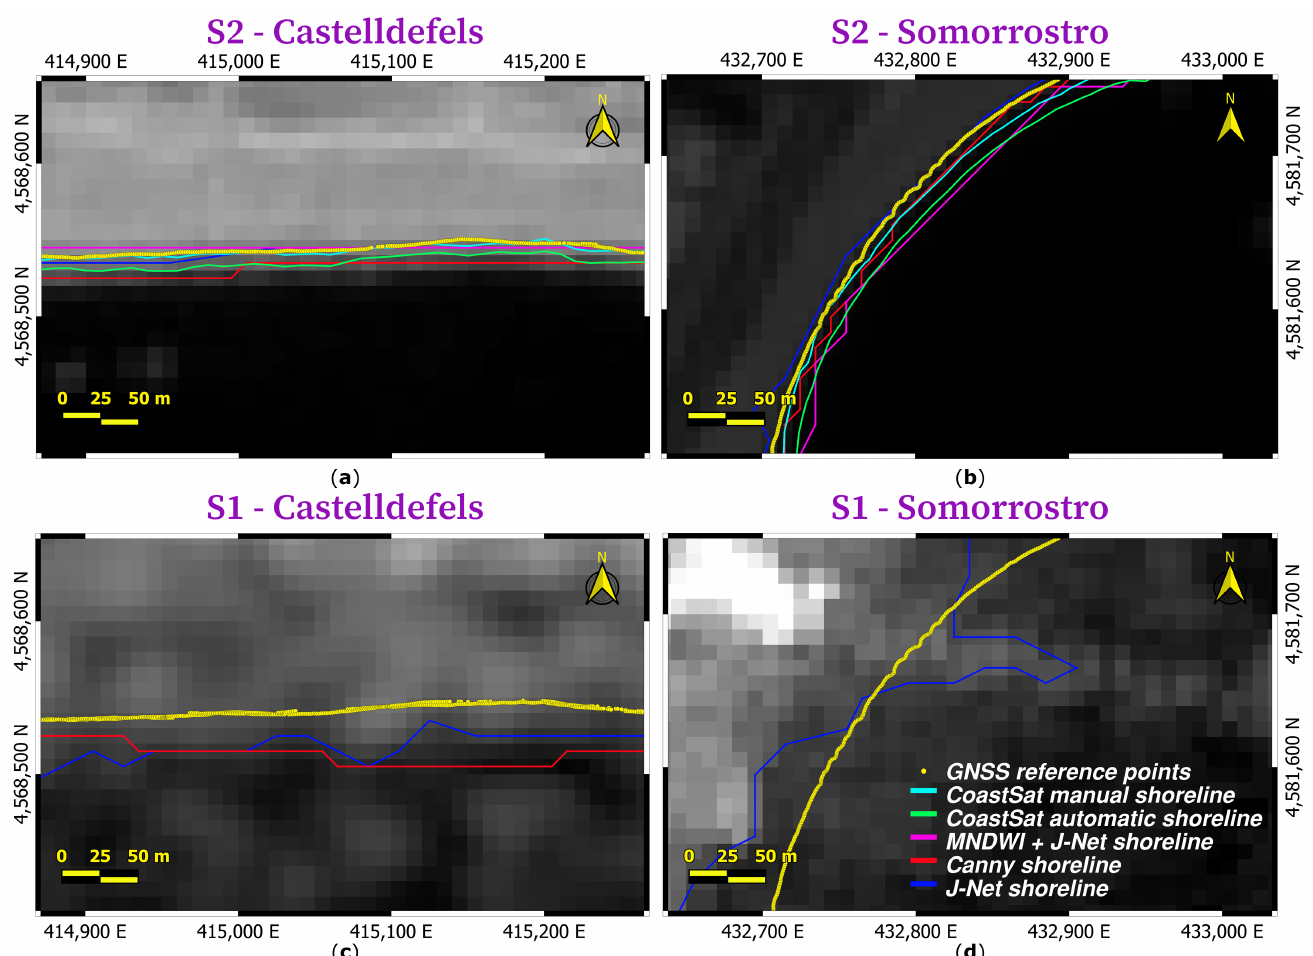
Figure 6. All extracted shorelines: ( a ) S2 Castelldefels, date 2017/06/02, ( b ) S2 Somorrostro, date 2017/10/10; ( c ) S1 Castelldefels 2017/05/31; ( d ) Somorrostro, dates 2017/10/04. GNSS reference points (yellow); CoastSat shoreline extracted with manual (light blue) and automatic (red) thresholds; shoreline extracted by J-Net Dynamic over the MNDWI image (pink); Canny-derived shoreline (red); J-Net Dynamic extracted shoreline